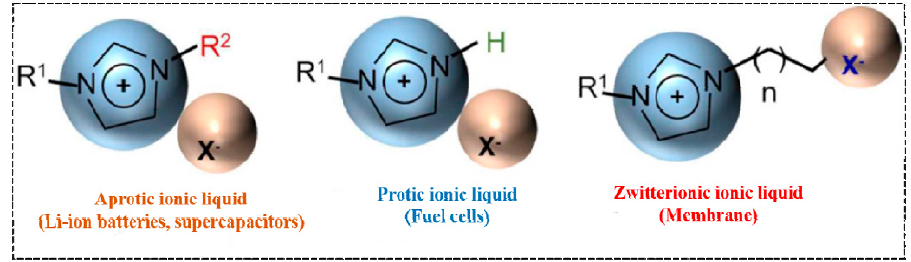
Figure 4. Based on composition, different types of ILs and their specific application, copyright; Reprinted with permission from Ref. [40]. Copyright 2009 Nature Materials. “Source: U.S. National Library of Medicine”.